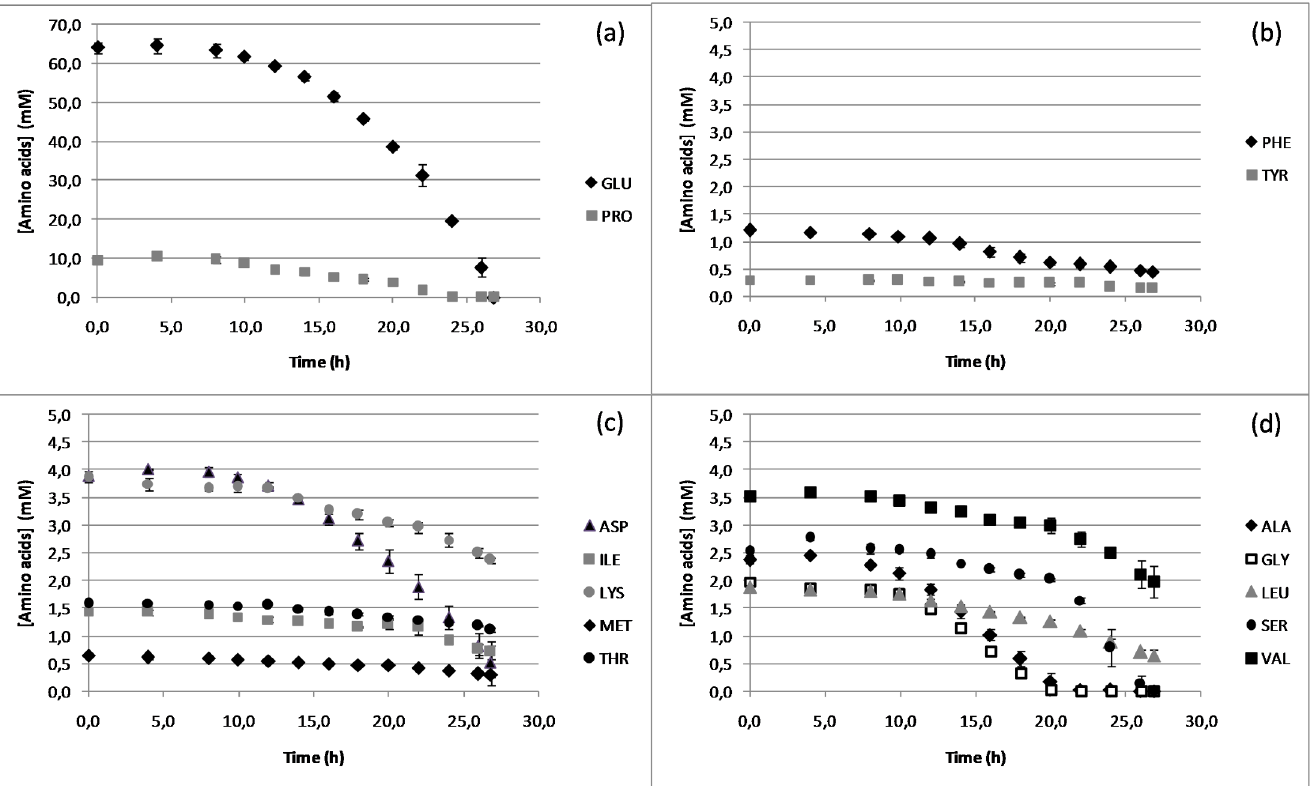
Fig 2. Kinetics of amino acid consumption of B . pertussis Tohama I in batches cultures. (a): Kinetics of glutamate and proline; (b) kinetics of aromatic amino acids; (c): kinetics of amino acids derived from pyruvate; (d): kinetics of amino acids derived from oxaloacetate. Results are displayed as mean values for the three biological replicates and error bars represent standard